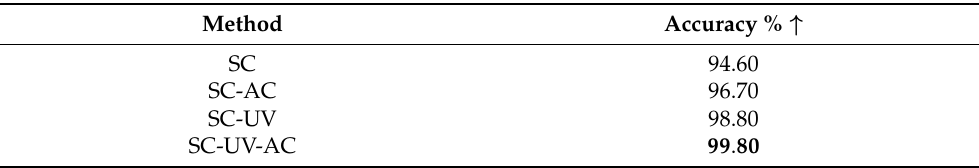
Table 1. Results of the ablation study.